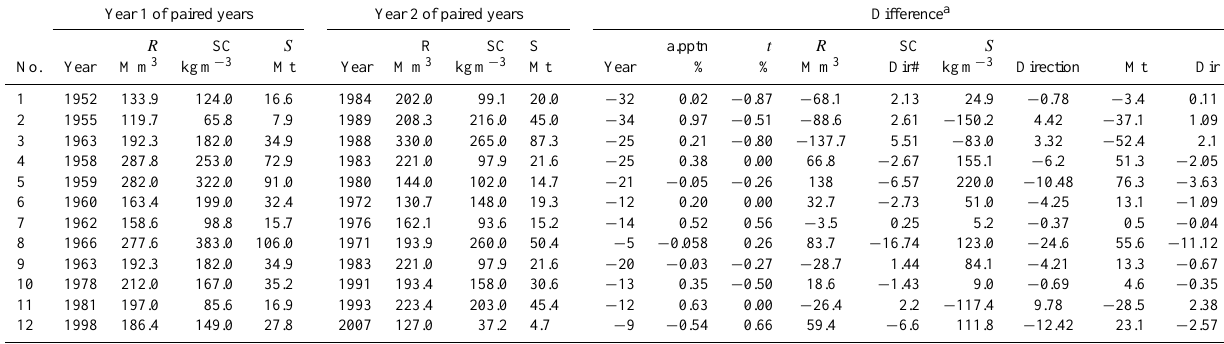
Table 4. Changes of runoff ( R ), sediment concentration (SC) and sediment load ( S ) within paired similar precipitation years. Year 1 of paired